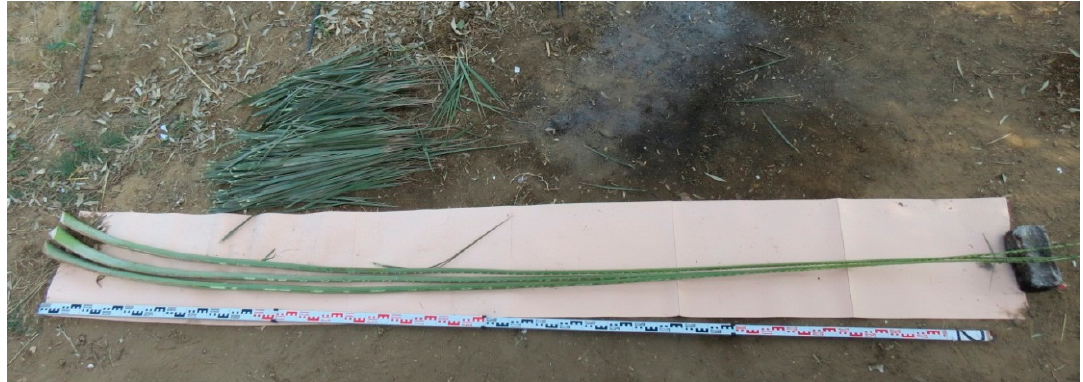
Figure 7. Date palm midribs and the removed leaflets of 3 midribs (Baladi species).